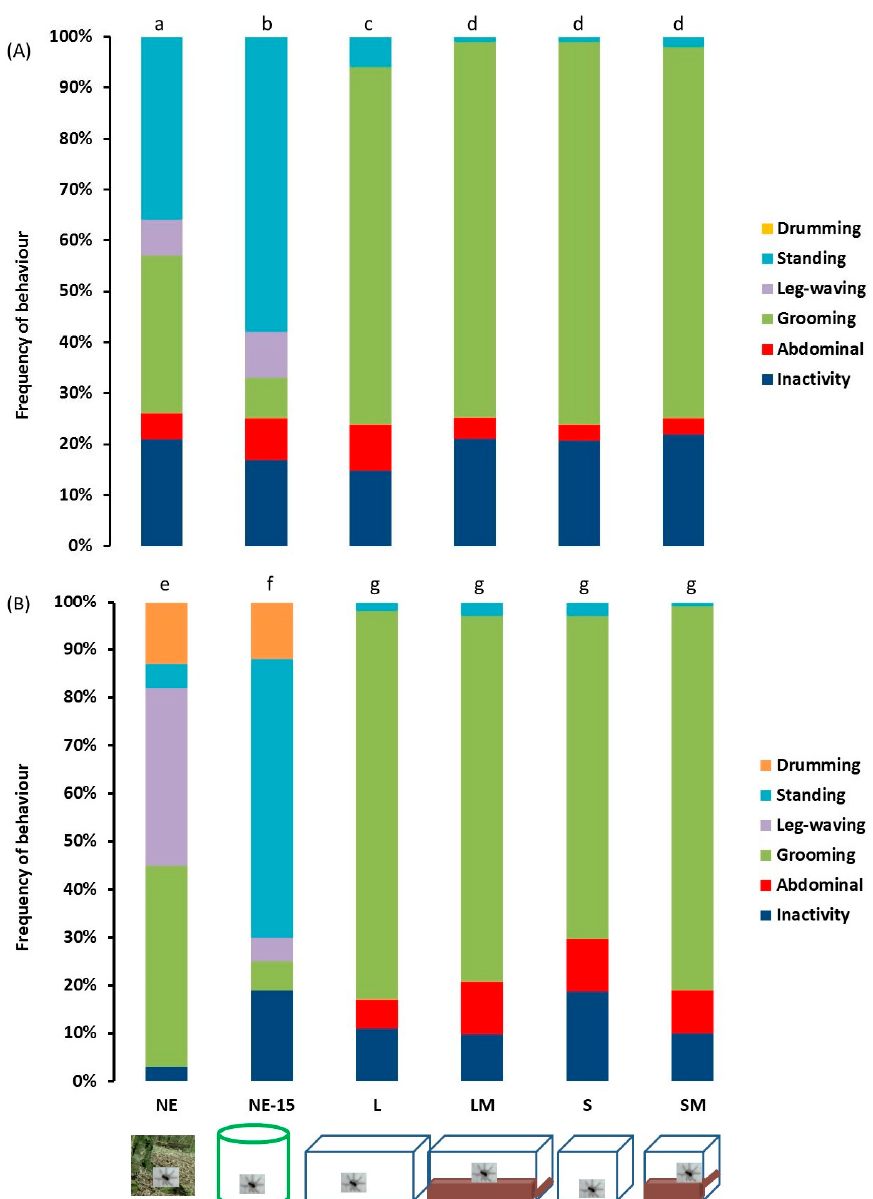
Figure 6. Spontaneous behavioural activities without changing position of adult female ( A ) and male ( B ) Pardosa saltans (in frequencies) in the open-field arena in relation to the environment where they developed: (NE) in their natural environment and tested 2–3 h after capture; (NE-15) in their natural environment and tested after 15 days in captivity; (L) in the laboratory in large terraria without matter on the base; (LM) in the laboratory in large terraria with matter on the base; (S) in the laboratory in small terraria without matter on the base; (SM) in the laboratory in small terraria with matter on the base. Frequencies of behaviours were compared using generalised linear mixed mod (GLMM, negative binomial distribution). Different letters indicate a significant difference ( p < 0.050, post hoc Wald